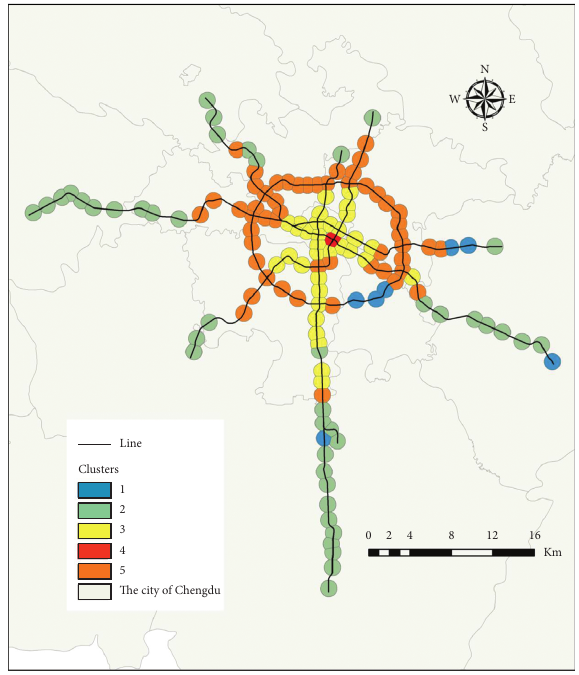
Figure 4: Clusters of subway